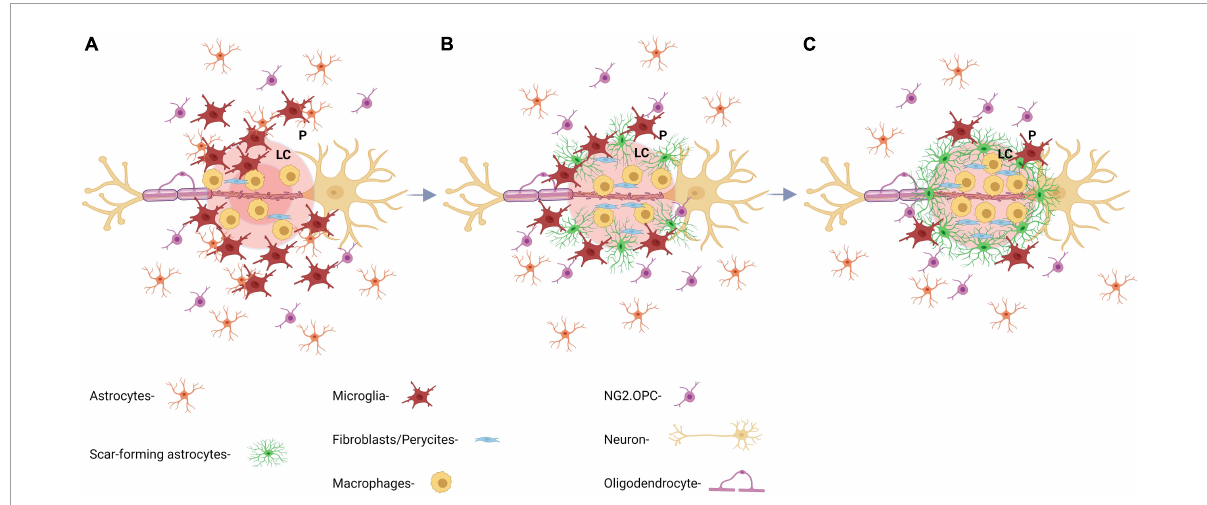
FIGURE2 Key aspects of the formation and maturation process of the glial scar. (A) At day 1 post-injury (dpi), there is an initial recruitment of reactive astrocytes by inflammatory microglia and macrophages releasing cytokines. Astrocytic processes are extended perpendicularly toward the lesion core. (B) At 7 dpi, astrocytic processes start to intertwine with each other making up the barrier region of the scar and forming a border between ECM and glial scar, which prevents further inflammation propagation. (C) At 14 dpi, the glial scar is considered mature and starts to shrink. GFAP expression decreases drastically after this time point and ECM continues to overexpress